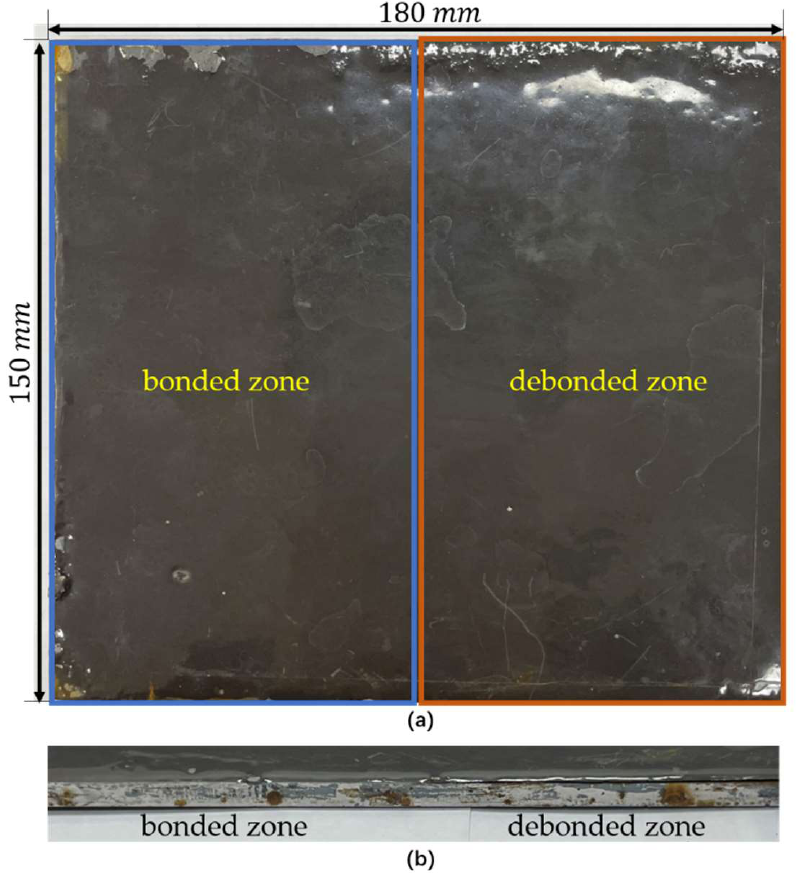
Figure 2. Photographs of specimen coated on the SS400 steel. ( a ) Top view and ( b ) cross-section. The left side is bonded zone, and the right side is debonded zone.